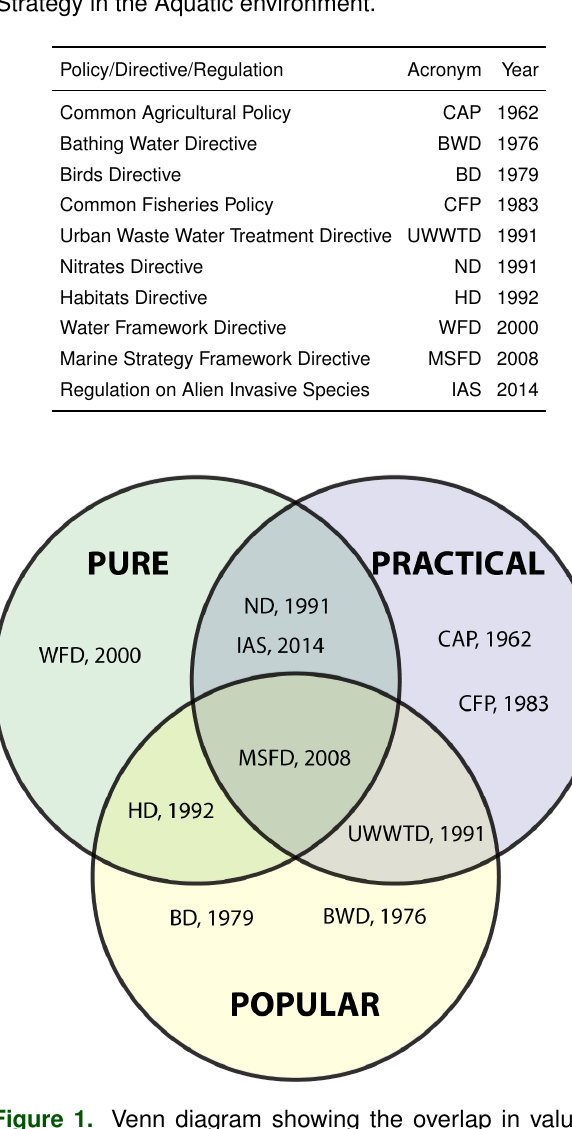
Figure 1. Venn diagram showing the overlap in values between different EU environmental directive and policies relating to the biodiversity in aquatic